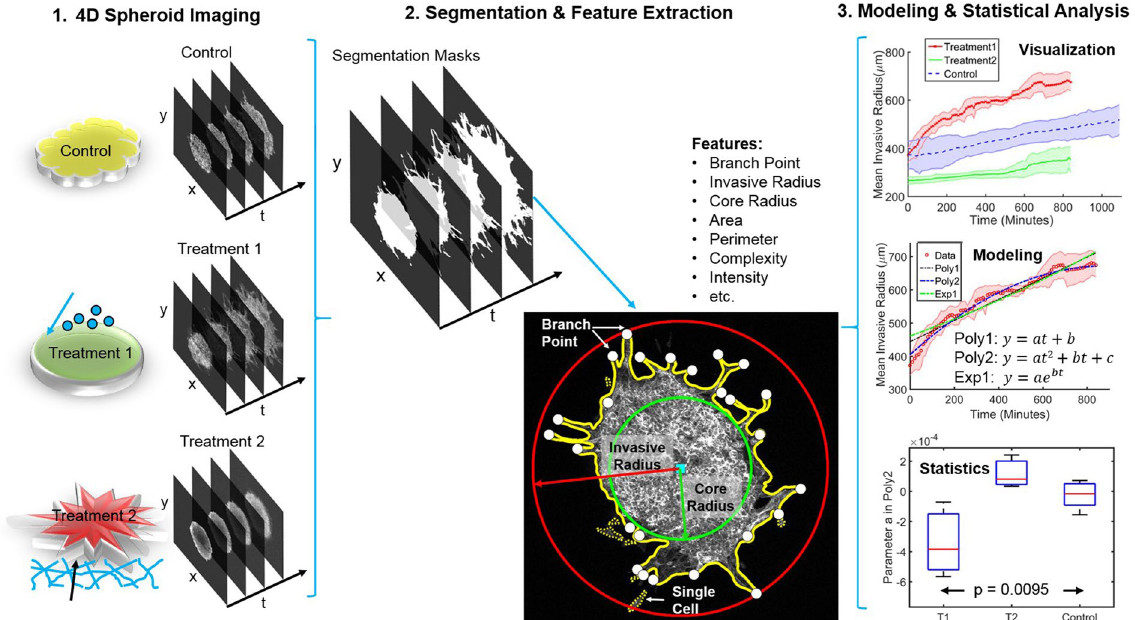
Figure 1. Overview of TASI framework. Step1 shows 4-dimensional (x, y, z, t) spheroid dynamic experiment and imaging. Step 2 shows the segmentation and morphology features extracted from the individual spheroid. Solid yellow line is the spheroid boundary. Dashed yellow lines are single cell boundaries. Red circle and red arrow represent the invasive radius. Green circle and green arrow represent the core radius. White dots are branch points and cyan square is centroid of the spheroid. Step 3 show the visualization, modeling and statistical analysis for grouped spheroid dynamics under different